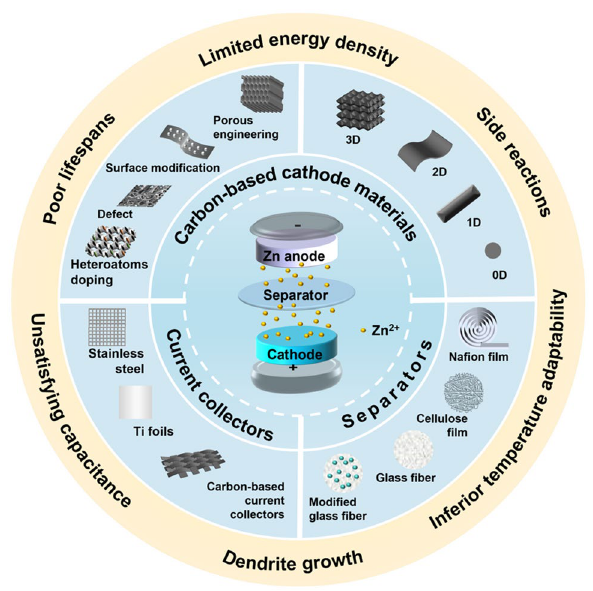
Fig. 2 The performance improvement approaches of carbon-based materials with different dimensions, the application of current col- lectors and separators in ZIHCs, and the challenges faced by ZIHCs today